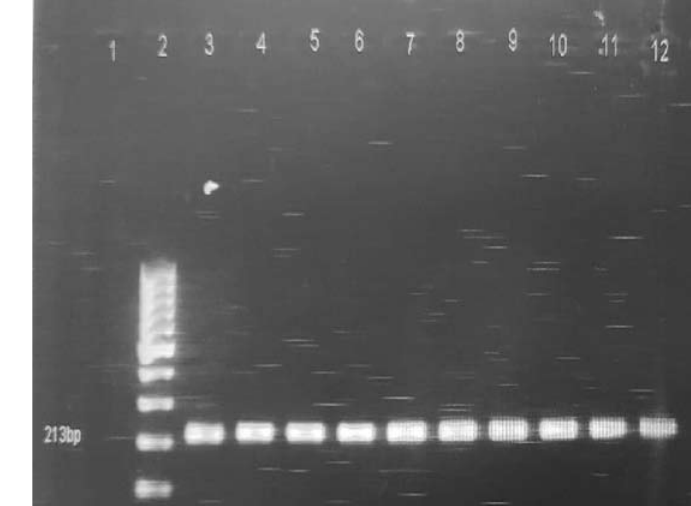
Fig. 1. Amplicons of Bordetella bronchiseptica